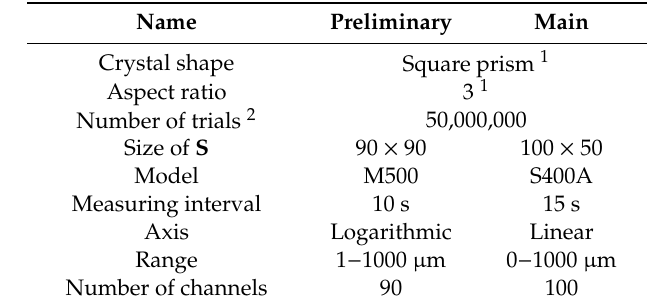
Table 2. Settings of the Monte Carlo analysis and instruments for focused beam reflectance measurement (FBRM) in the preliminary and the main